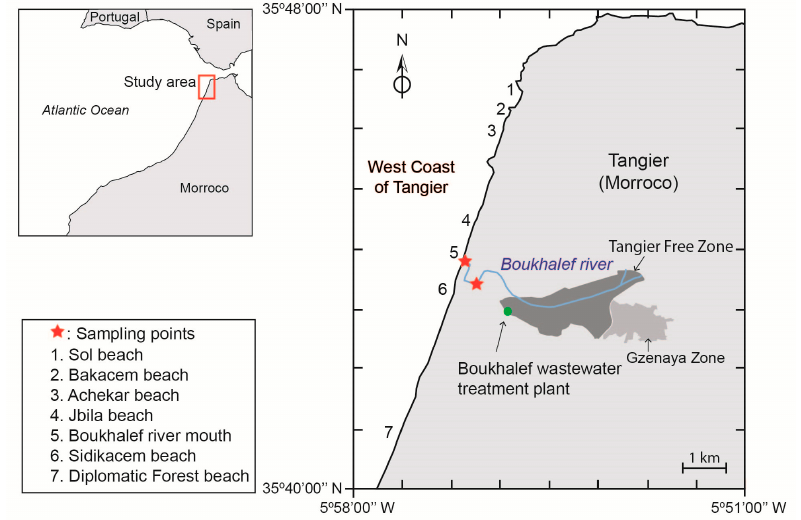
Figure 1. Study area in the west coast of Tangier, northern Morocco, with locations of two sampling points, beaches of the west coast of Tangier, the Boukhalef River, and the industrial